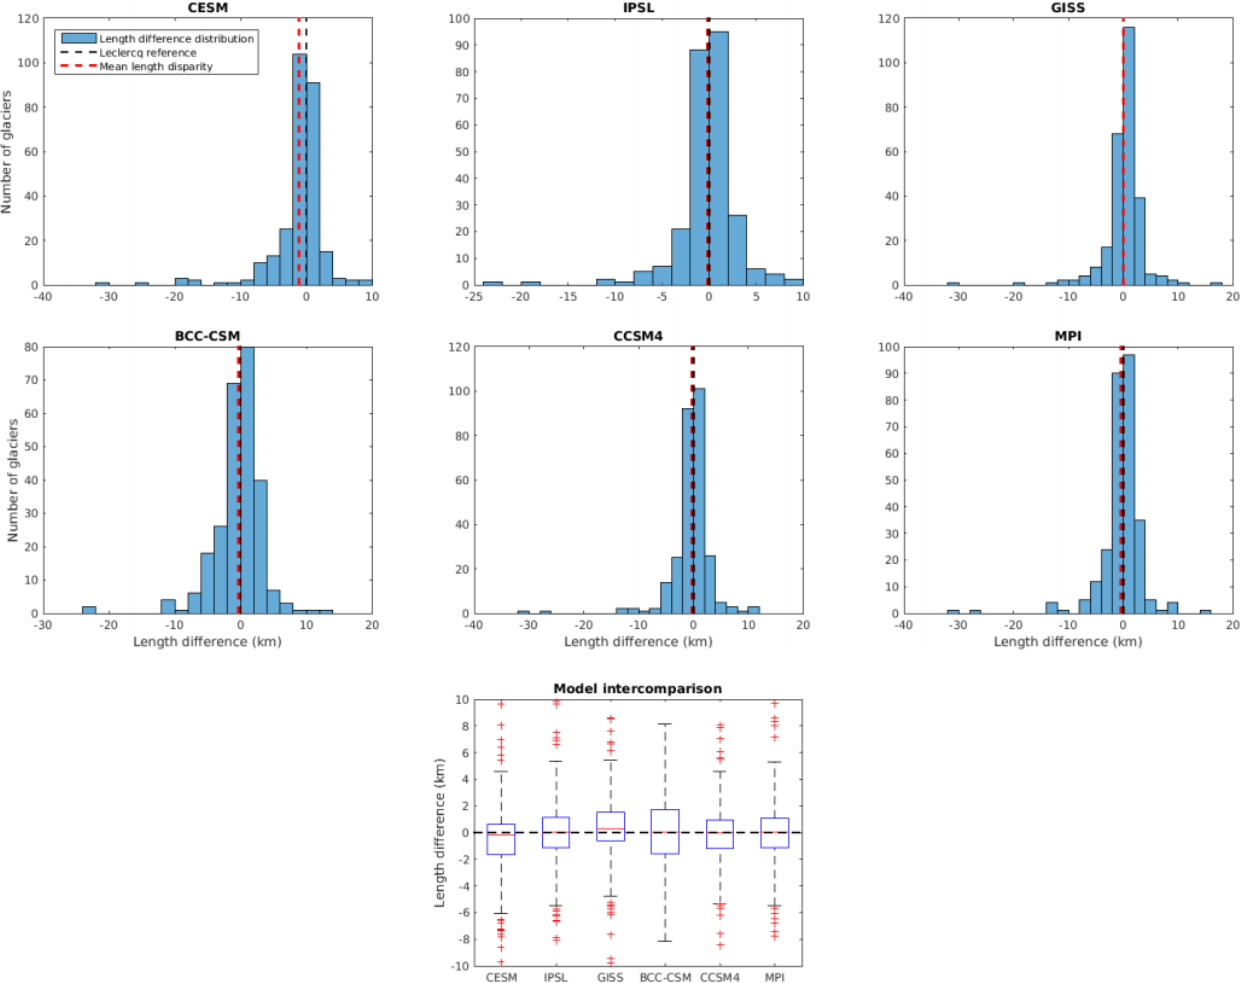
Figure 6. Distribution of the errors in absolute modelled glacier length in 1950. Data is displayed for each GCM for all modelled glaciers globally, rather than for each region, due to small sample sizes in several regions. The model intercomparison panel shows box plots with the box representing interquartile